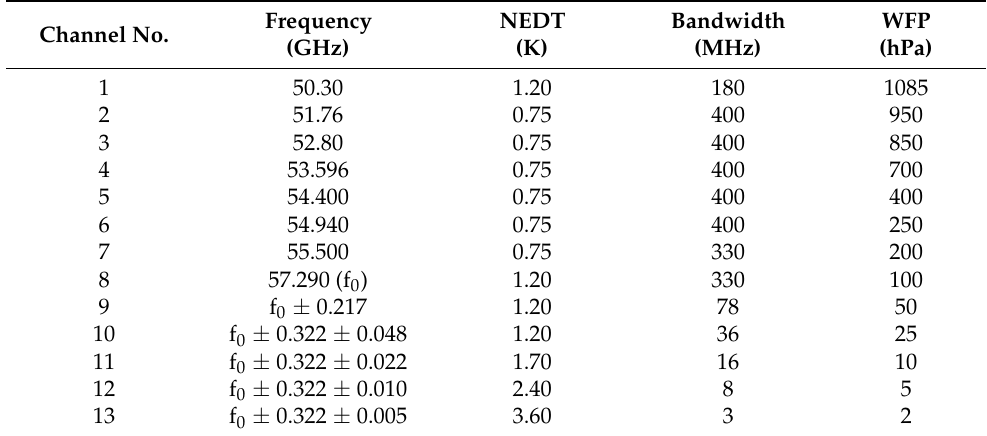
Figure 1. FY-3D MWTS-2 field of view (FOV) footprints with a 1.1 ◦ beam width along a single scan line (green ovals), as well as the 2nd (blue ovals), 9th (cyan ovals), 25th (orange ovals), and 45th (red ovals) in the along-track direction over a portion of the swath on 7 August 2019. The background image shows the FY-4A AGRI 10.7 µ m channel observations at 0500 UTC on 7 August 2019. The center of Typhoon Lekima at this time was located at (127.9 ◦ E, 20.8 ◦ N). Table 1. Channel number, frequency, noise equivalent differential temperature (NEDT), bandwidth, and weighting function peak (WFP) of FY-3D MWTS-2.